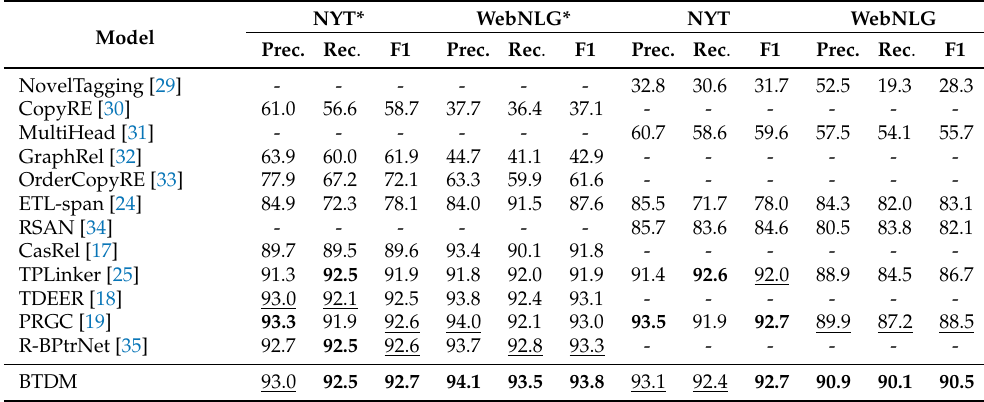
Table 2. Comparison (%) of the proposed BTDM method with the baselines. Note Bold marks the highest score and underline marks the second best